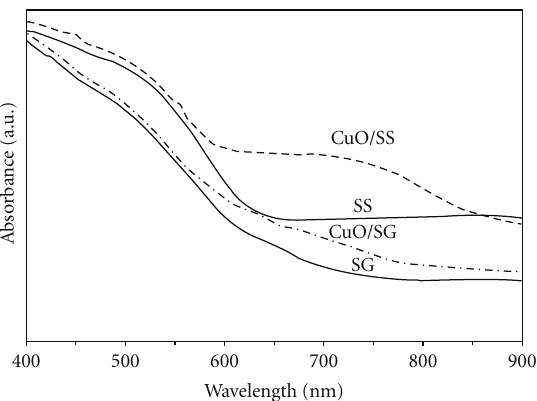
Figure 6: UV-vis absorption spectra during photodegradation of indigo carmine under solar light irradiation using CuO/SG.